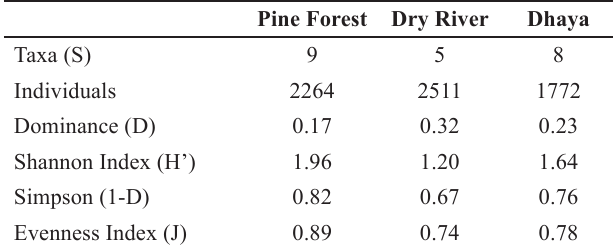
Table 3. Diversity indexes and Evenness for the three habitats.